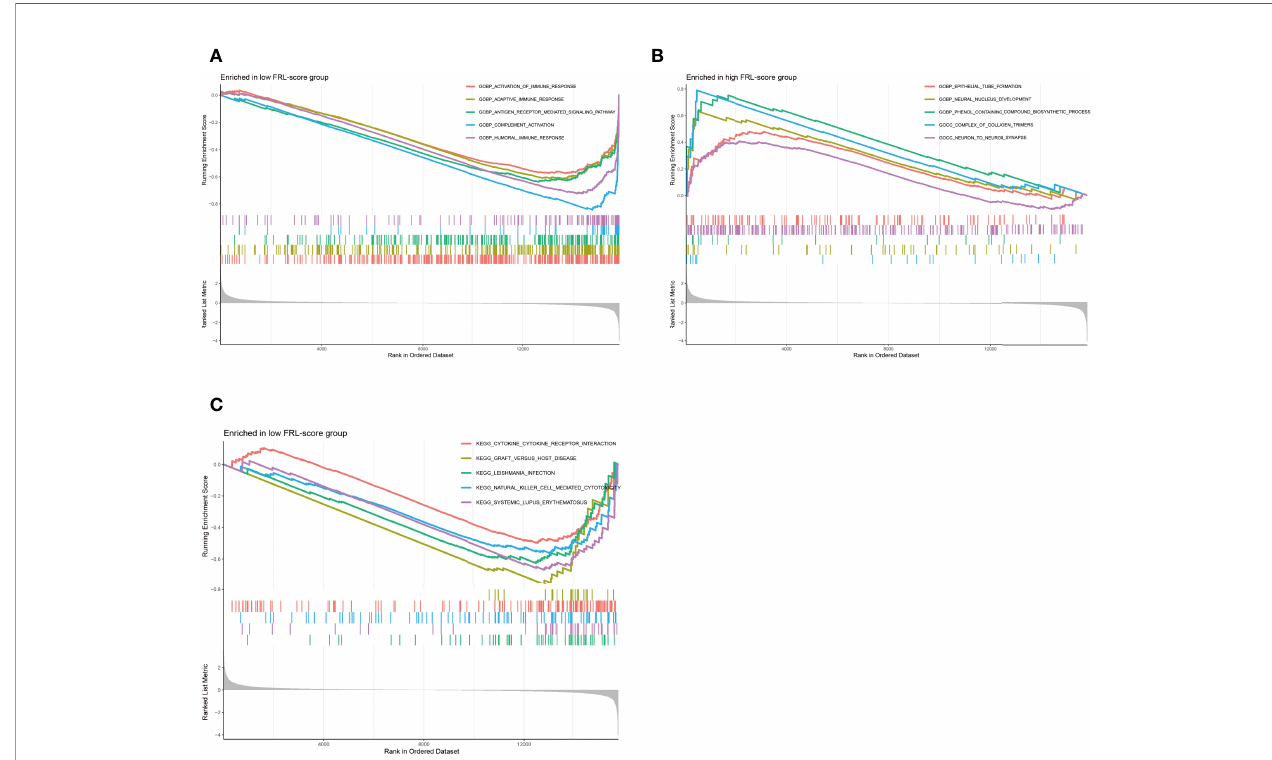
FIGURE 8 | Gene set enrichment analysis of different FRL-score subgroups. (A) GO enrichment analysis of low FRL-score group. (B) GO enrichment analysis of high FRL-score group. (C) KEGG enrichment analysis of low FRL-score group.